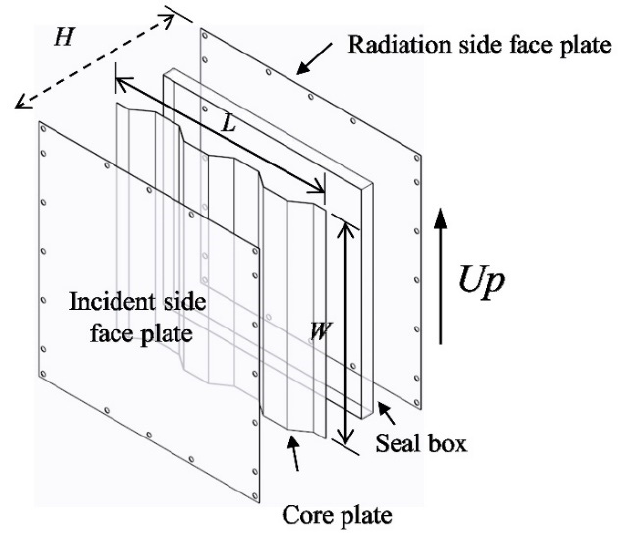
Figure 31. The test specimen configuration.